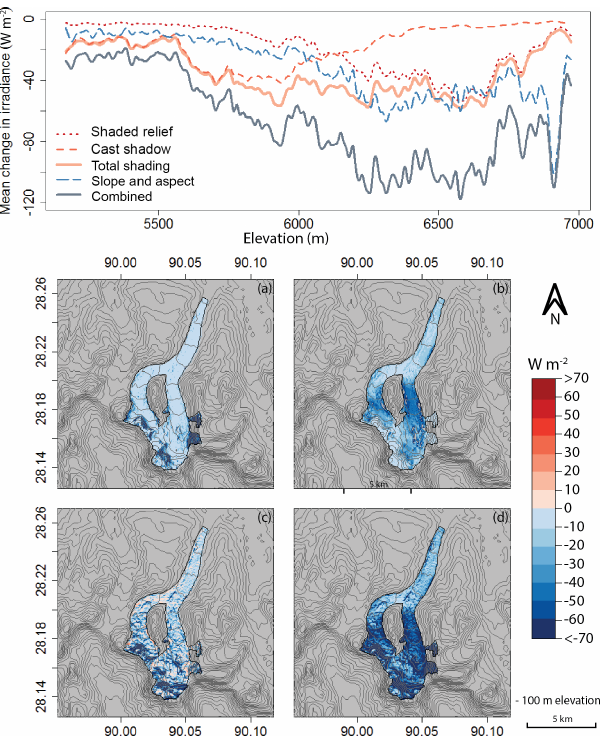
Figure 4. Satluj Glacier. Mean change in irradiance throughout the summer melt season due to shaded relief (a) , cast shadowing (b) , slope and aspect (c) , and combined topographic components (d) . A smoothing spline was fit to the irradiance change values along the elevation profile of the glacier. The effect of cast shadowing appears to be more significant than that of shaded relief and slope and aspect at lower elevations where ablation dominates during the melt season.